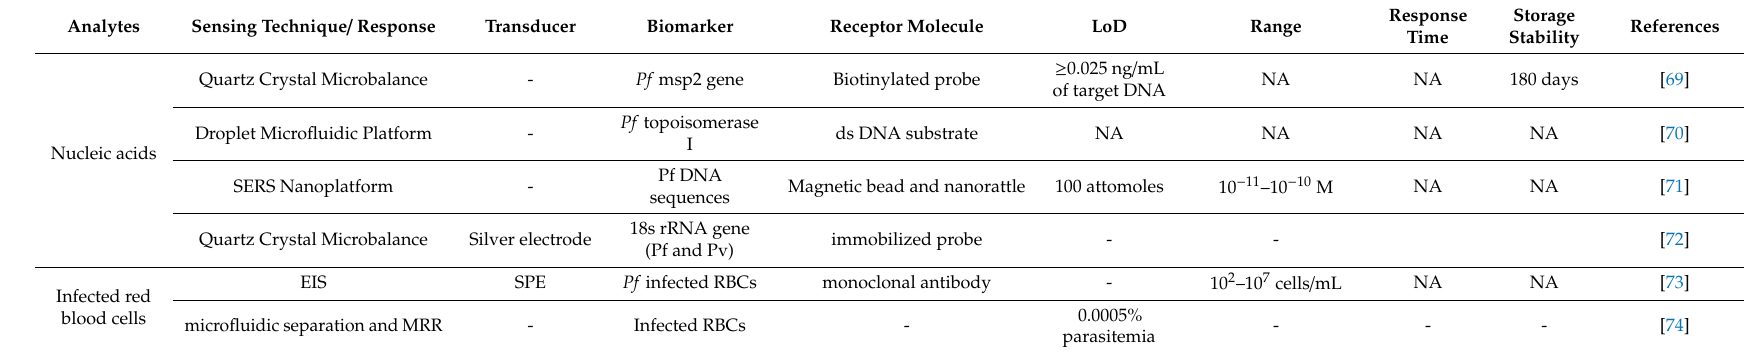
Table 2. Summary of selected biosensors reporting detection of various malaria